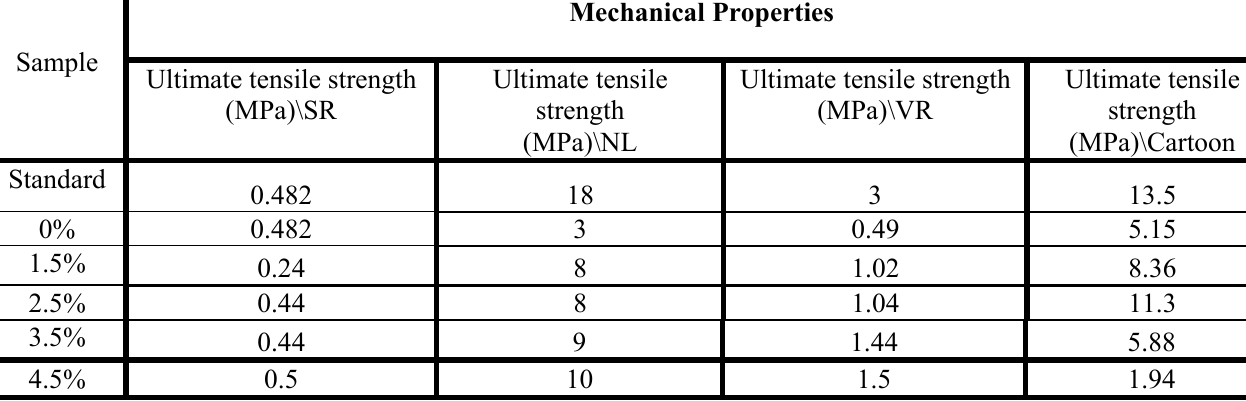
Table 2: Main mechanical properties of SR, NL, VR, cartoon sample for ultimate tensile strength